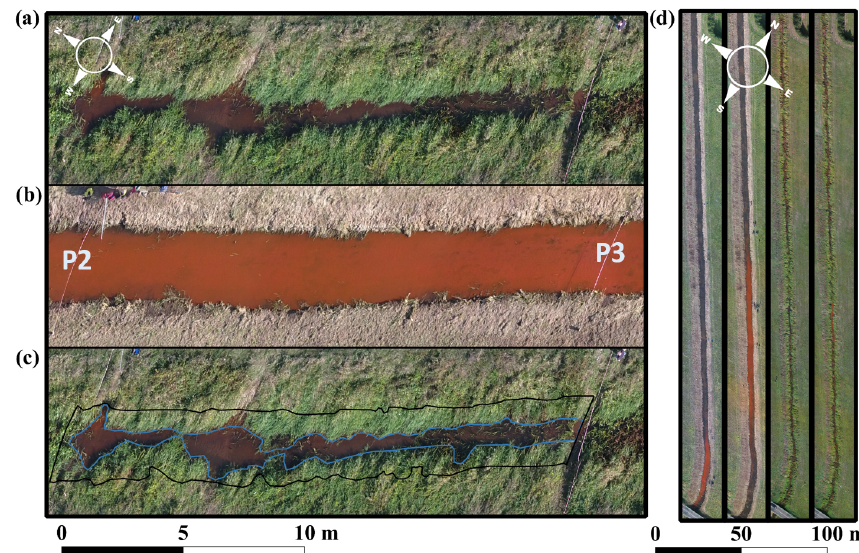
Figure 6. Aerial image of the sub-reach B, captured in (a) fully vegetated (Exp. 1) and (b) fully cut (Exp. 2) conditions. (c) The surface coverage of vegetation was determined by computing the ratio of the vegetation-covered surface area and the total wetted surface area available from the bare-channel scenario. (d) Example orthophotos of the entire analysed reach taken during the tracing, with the two leftmost photos showing the cut condition and the two rightmost photos showing the vegetated